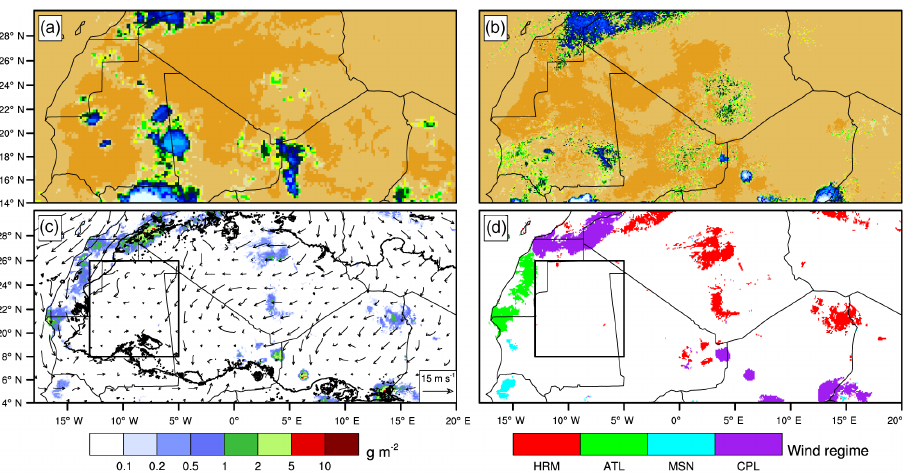
Figure 5. Fields at 21:00UTC 20 June 2011. Top row: brightness temperature (a) from SEVIRI observation and (b) from MNH05. Bottom row: (c) 3-hourly dust emission and (d) attributed wind regime from MNH05. HRM, ATL, MSN and CPL stand for harmattan, Atlantic flow, monsoon flow and cold pool, respectively. In (c) , the line represents the mixing ratio of water vapour at 2m equal to 10gkg − 1 and the arrows represent the wind field at 2m. In (c, d) , the black rectangle shows the domain of analysis.